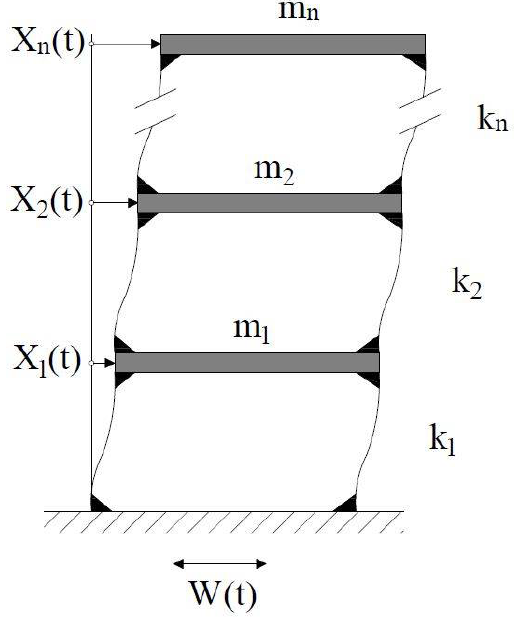
Figure 2. General MDoF shear-type frame used for the numerical simulations.